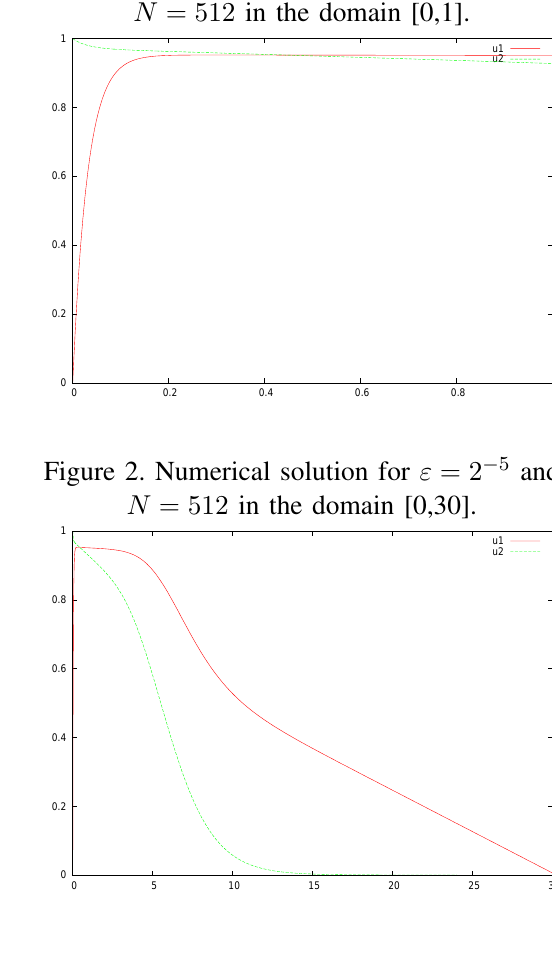
Figure 1. Numerical solution for ε = 2 − 5 and N = 512 in the domain [0,1].